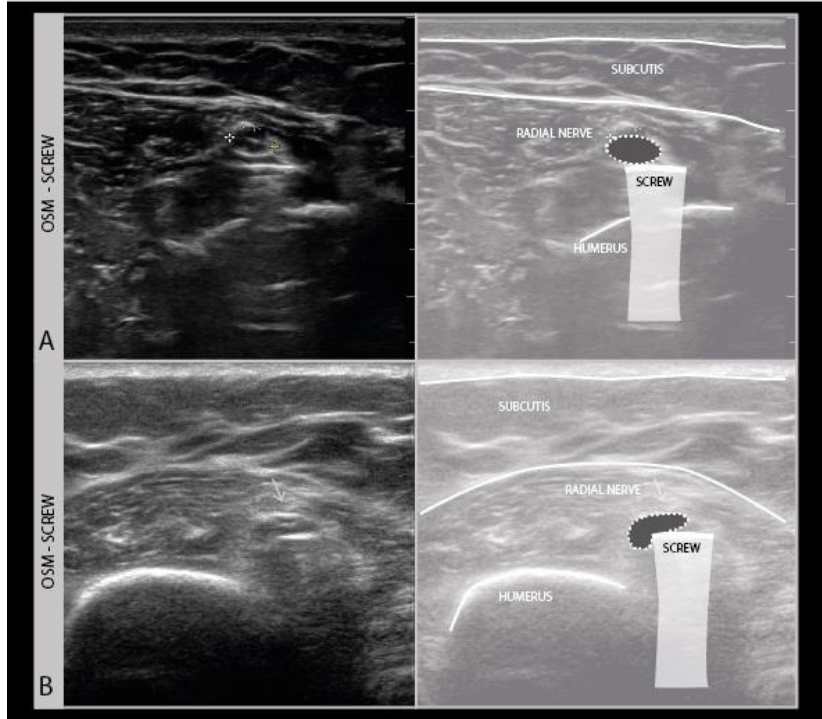
Figure 4. Two different examples ( A and B ) of the radial nerve crossing over a mid-humerus osteosynthesis material (OSM) screw (high frequency -18 MHz).